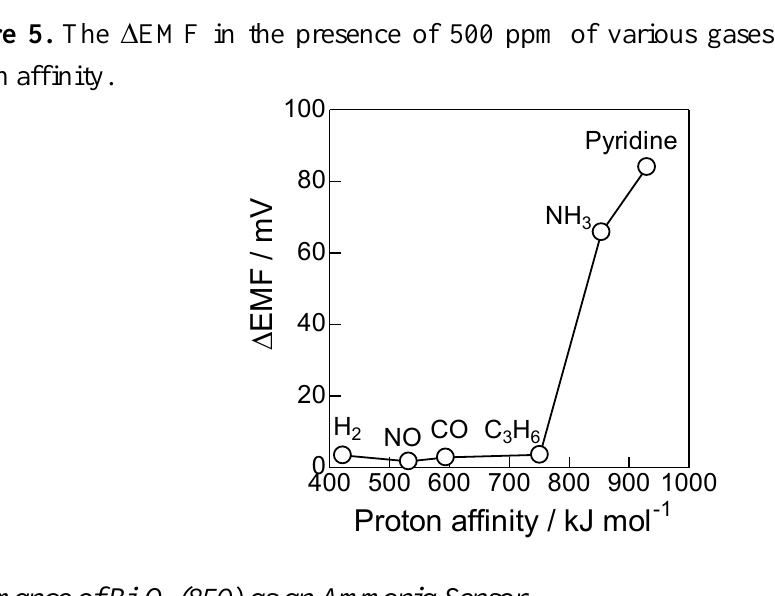
concentration at 600 3